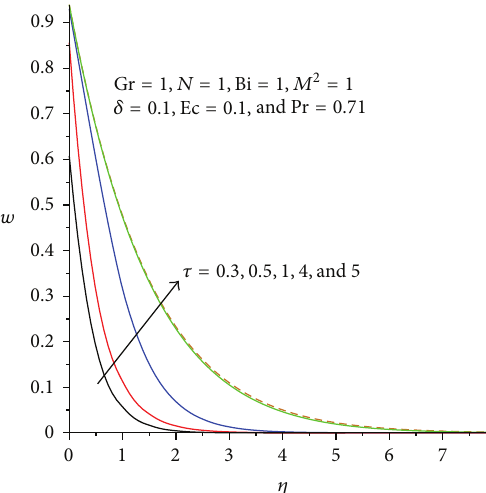
Figure 3: Velocity profiles with increasing time.